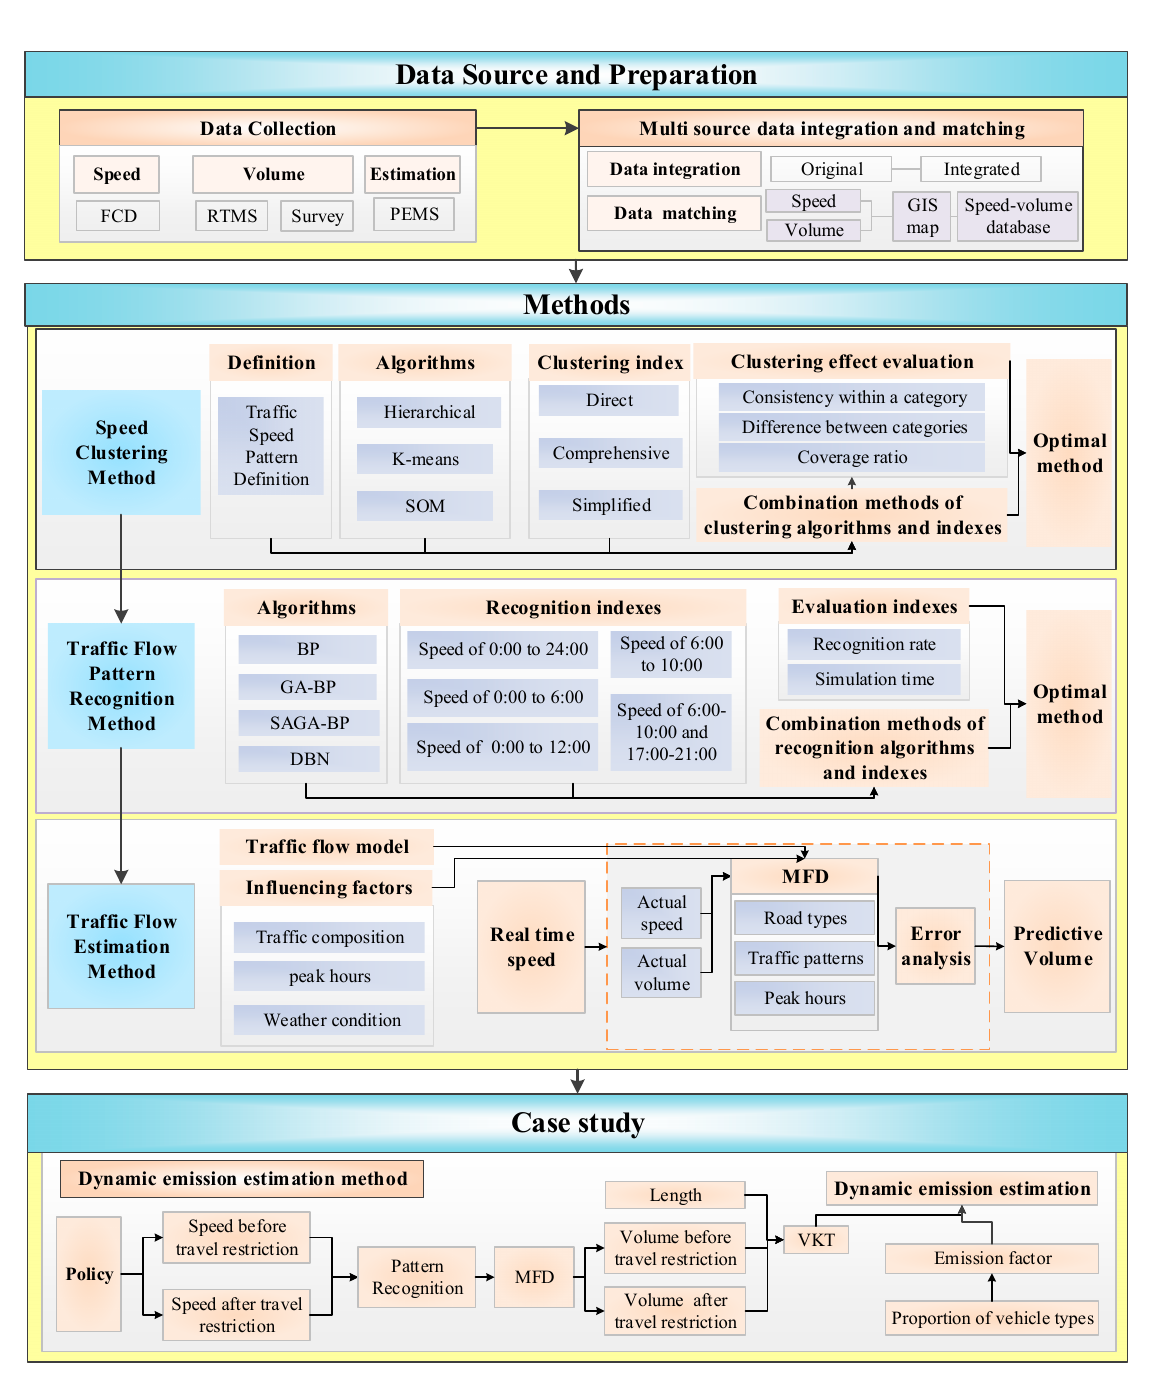
Figure 1. Methodology flow chart.